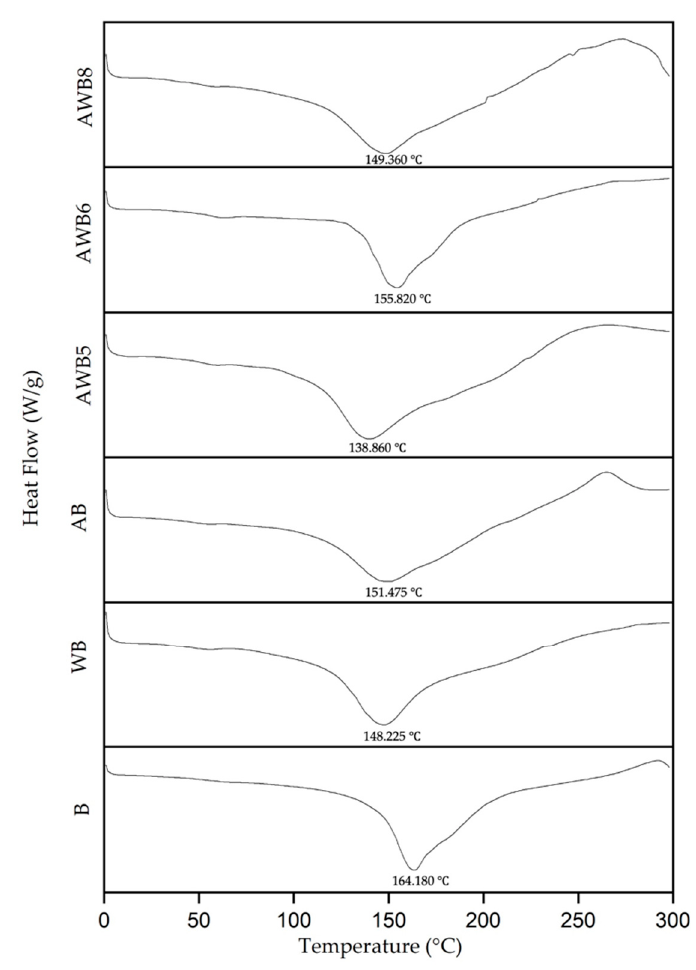
Figure 5. Thermogram of S. boulardii encapsulations using agavins and whey protein as wall materials at different concentrations.